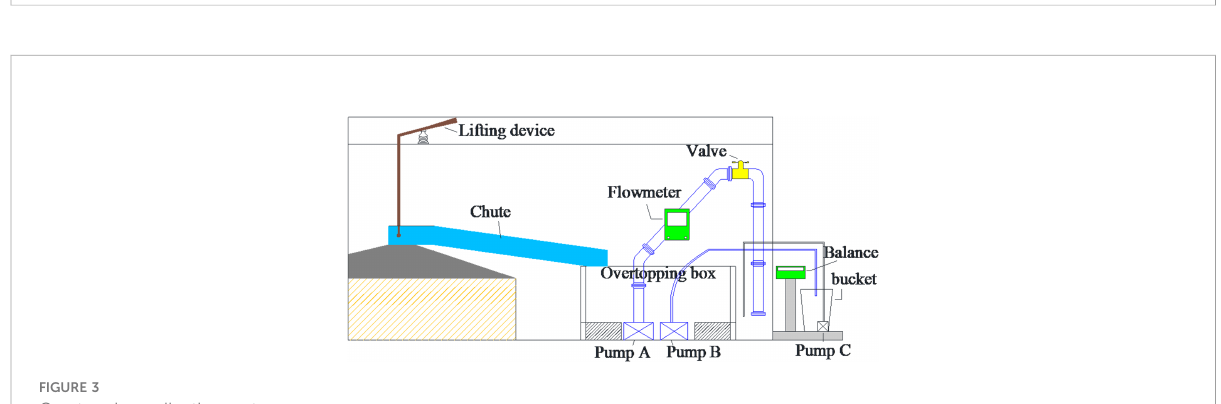
FIGURE 3 Overtopping collection system.